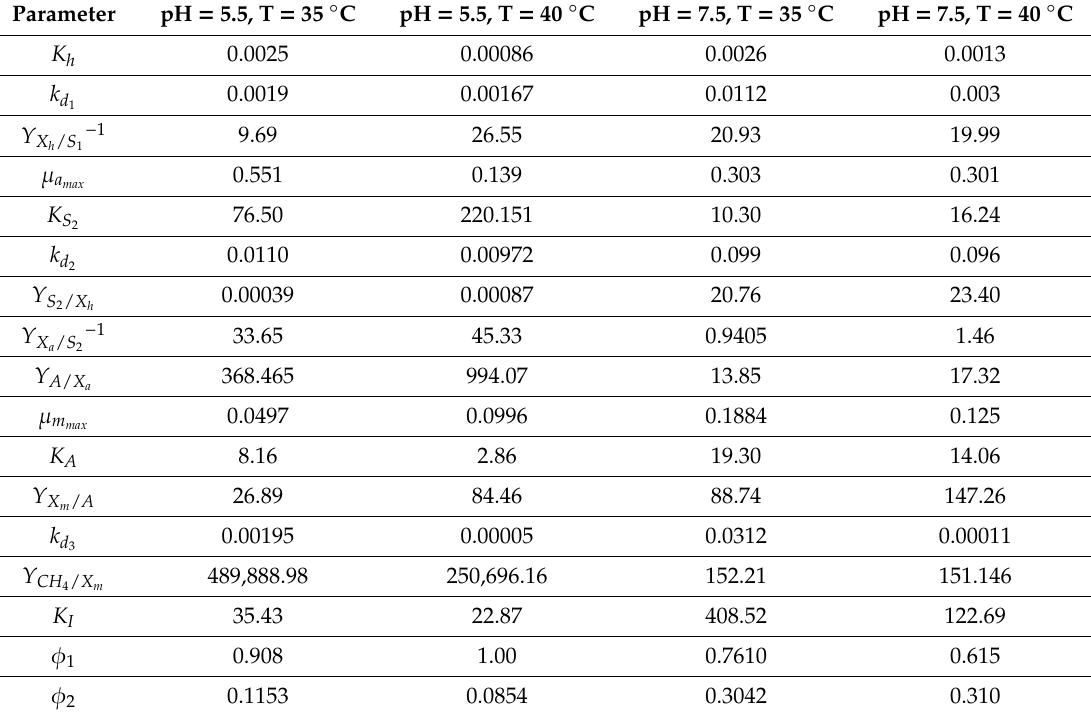
Table 3. Estimated parameters of proposed mathematical model to four operation